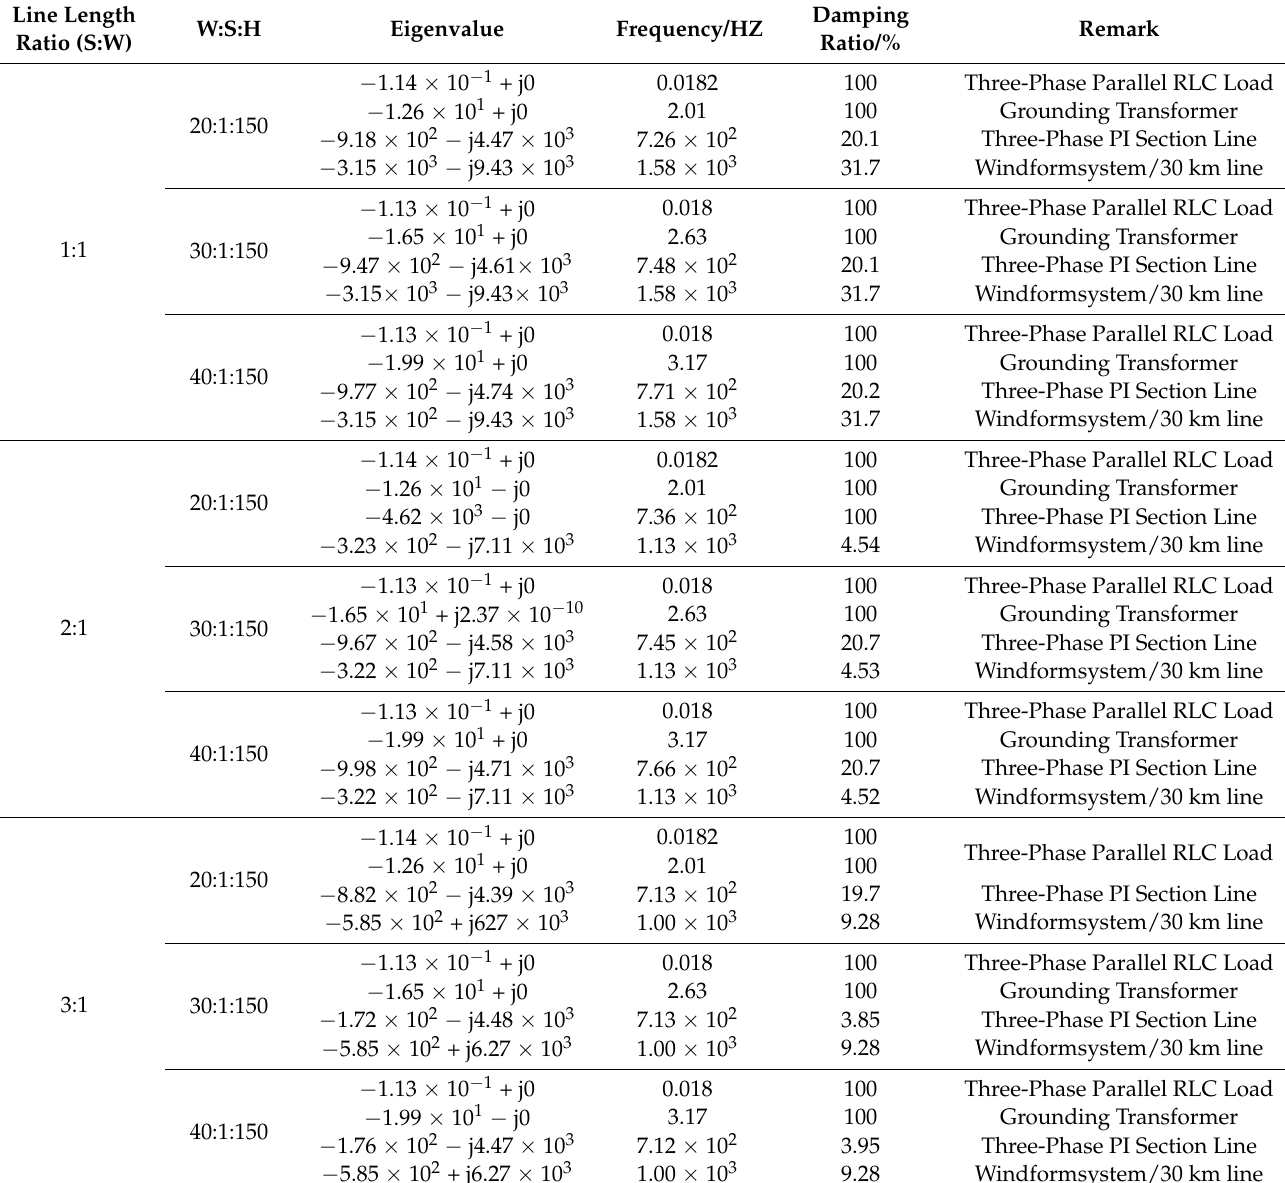
Table 1. Low frequency oscillation response of hydropower system to wind/solar/hydropower quota and line distance ratio. Line Length Ratio